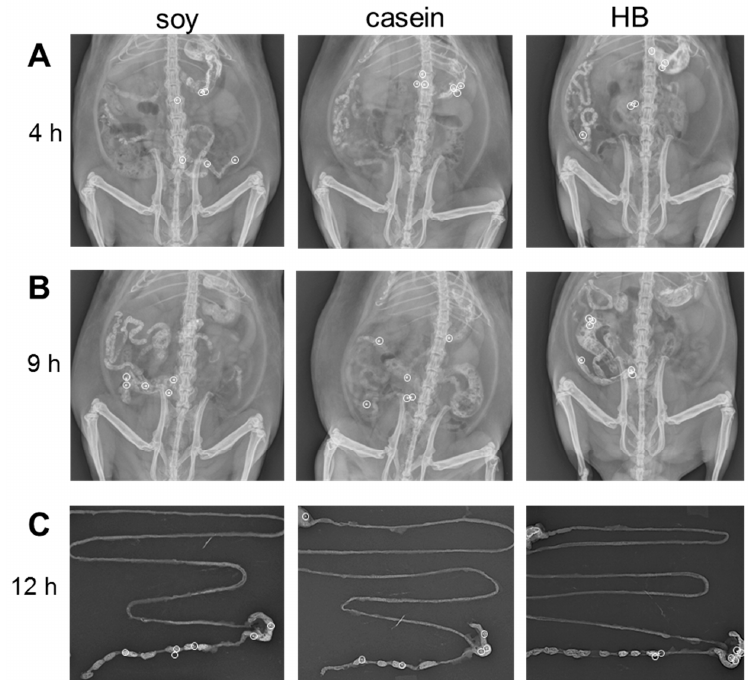
Figure 2. Location of six metallic beads tracked over time for animals treated for soy or milk protein diets. Representative examples of bead location are shown at: ( A , B ) 4 h and 9 h in vivo and ( C ) post-mortem GI tract at 12 h of X-ray images in ventral view for animals on soy, casein, and hydrolyzed blend (HB) diets (treated with DMSO).